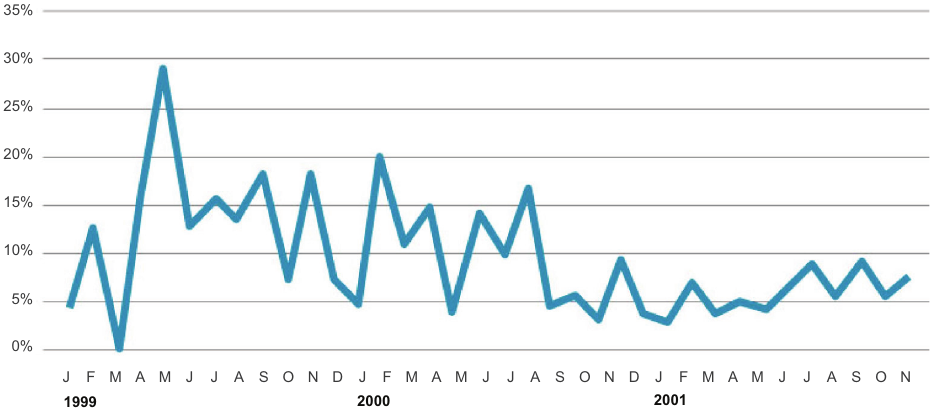
Figure 3. Tver Oblast, Russia: percentages of neonates with respiratory distress who died in the first week of life. As a result of the improvement, fewer neonates died in the first week of